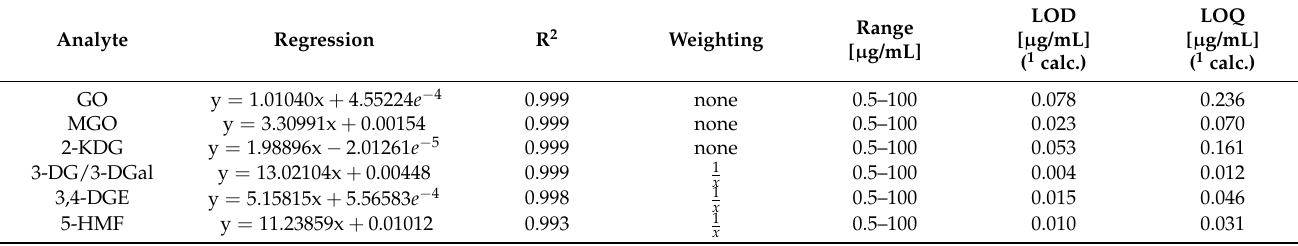
Table 10. Method validation parameters.